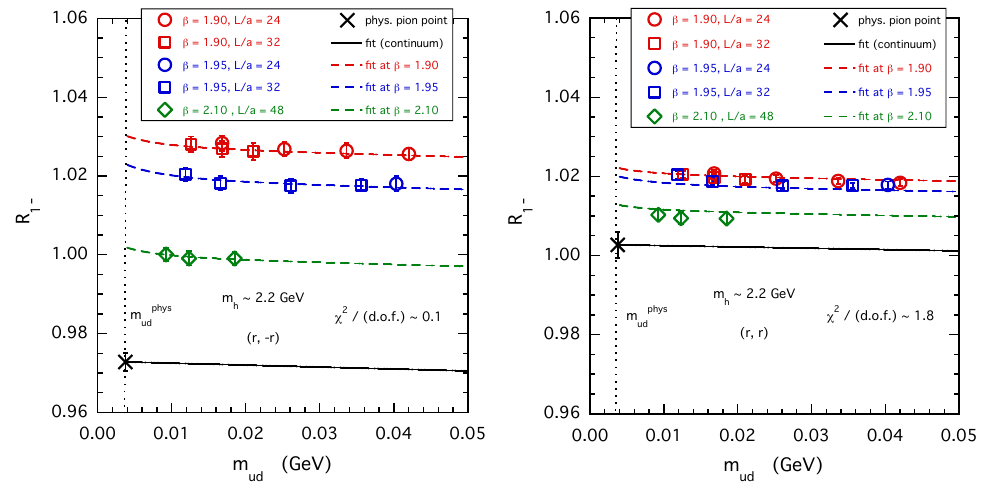
Figure 6 . Light-quark mass dependence of the ratio of the susceptibilities corresponding to eq. (A.21) for j = 1 − and n = 5 for the two combinations ( r, − r ) (left panel) and ( r, r ) (right panel) of the Wilson r -parameters. The solid lines represent the results of the fitting function (A.25) evaluated in the continuum and infinite volume limits, while the dashed ones correspond to the fitting function evaluated at each value of β and for the largest value of L/a . The crosses represent the value of the ratio extrapolated at the physical pion point ( m = m phys ) and in the continuum and infinite ud ud volume